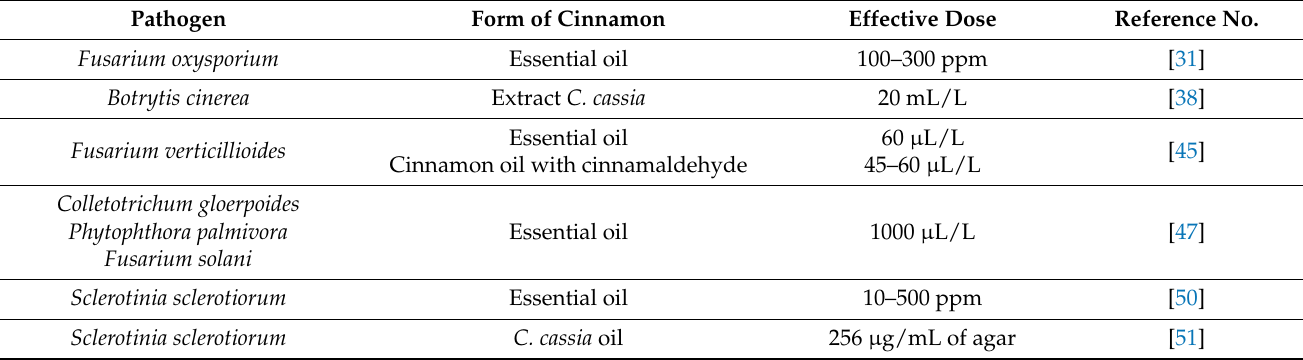
Table 2. Selected examples of fungicidal activity of cinnamon components for agricultural purposes.